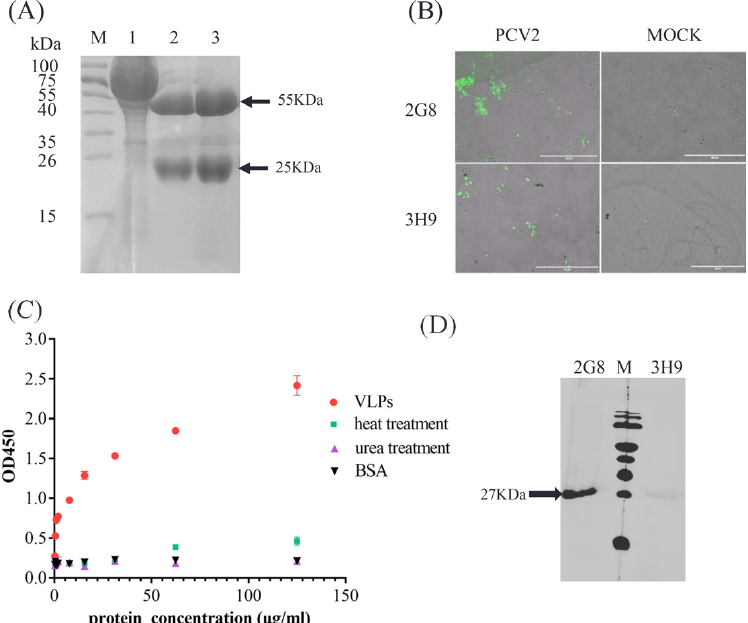
Figure 1. Generation and characterization of mAbs. ( A ) SDS-PAGE analysis was performed to assess the purity of antibodies. Lane1, marker; lane 2, antibody ascites; lane 3, mAb 2G8; and lane 4, mAb 3H9. ( B ) IFA was performed to test the purified mAbs reaction to the PCV2. PK-15 cells infected or mock-infected with PCV2 were incubated with purified mAbs 2G8 and 3H9, followed by incubation with a FITC-labeled anti-mouse antibody. ( C ) Indirect ELISA was performed to test the PCV2 specificity. Dilutions from 125 µ g/mL to 0.244 µ g/mL of VLPs heat and denaturant urea-treated VLPs and BSA protein were coated, and mAb 3H9 was added, followed by HRP-labeled anti-mouse antibody. The values at OD450 were read. Error bars represent standard deviation (N = 3). ( D ) The reactivity and specificity of mAbs 2G8 and